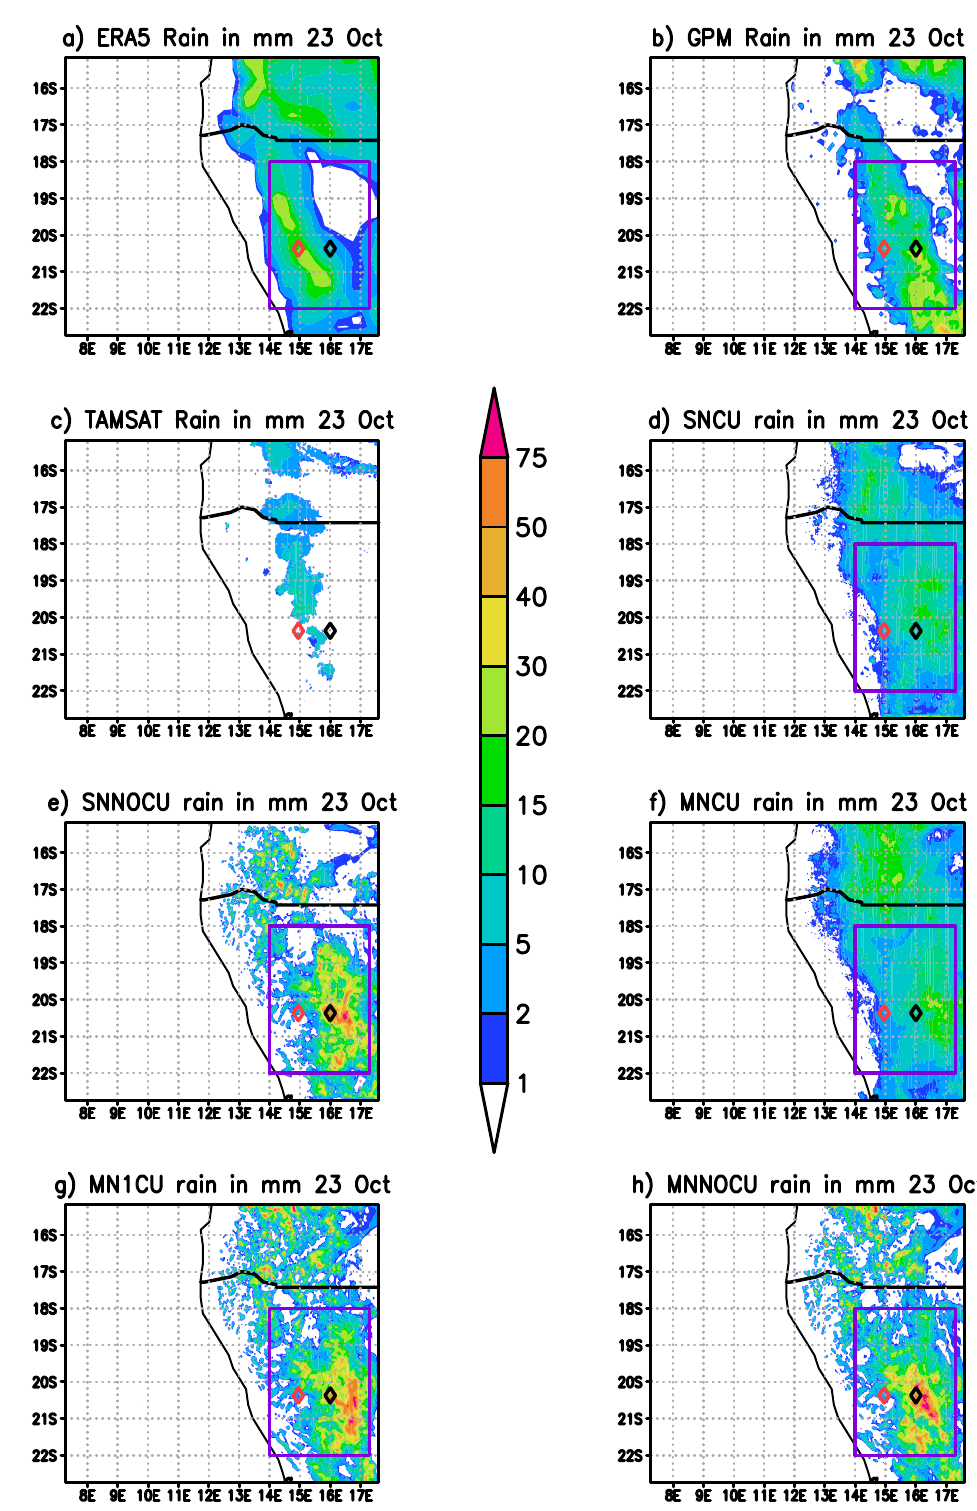
Figure 4. ( a ) shows the observed total 24 h rainfall (mm) for ERA5, ( b ) GPM, ( c ) TAMSAT, and simulations for ( d ) SNCU, ( e ) SNNOCU, ( f ) MNCU, ( g ) MN1CU, and ( h ) MNNOCU. The red diamond represents Khorixas, and the black diamond is a point chosen which has more rainfall simulated. The purple rectangle shown the area for which Figure 6 is plotted.